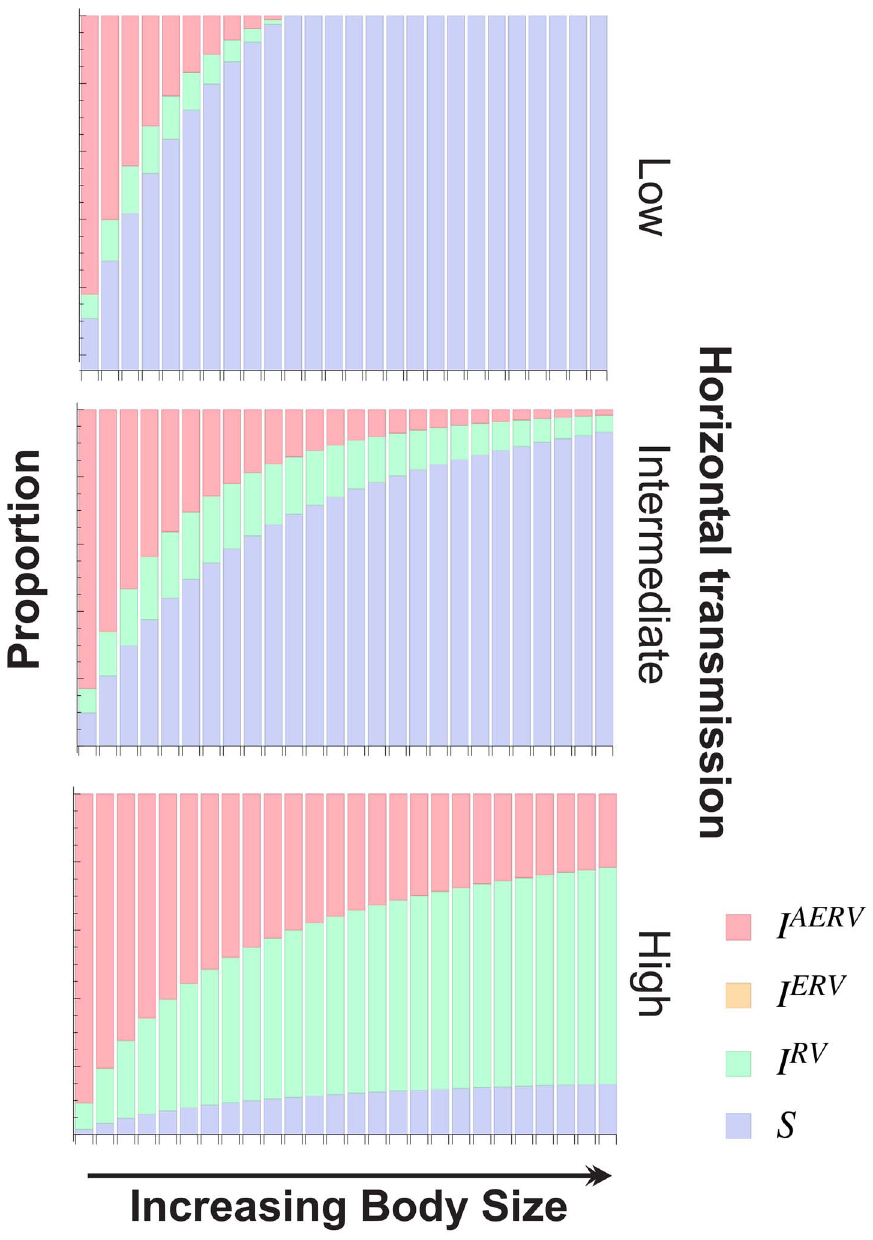
Figure 5. The effect of body size (B) for different horizontal transmission rates ( l ) on the structure of the population at equilibrium. At high rates of horizontal transmission ( l ), the proportion of infected individuals reaches a plateau for increasing body sizes. Moreover, in this case, for larger body sizes, there is a greater proportion of exogenous retrovirus infections than there are endogenous ones.